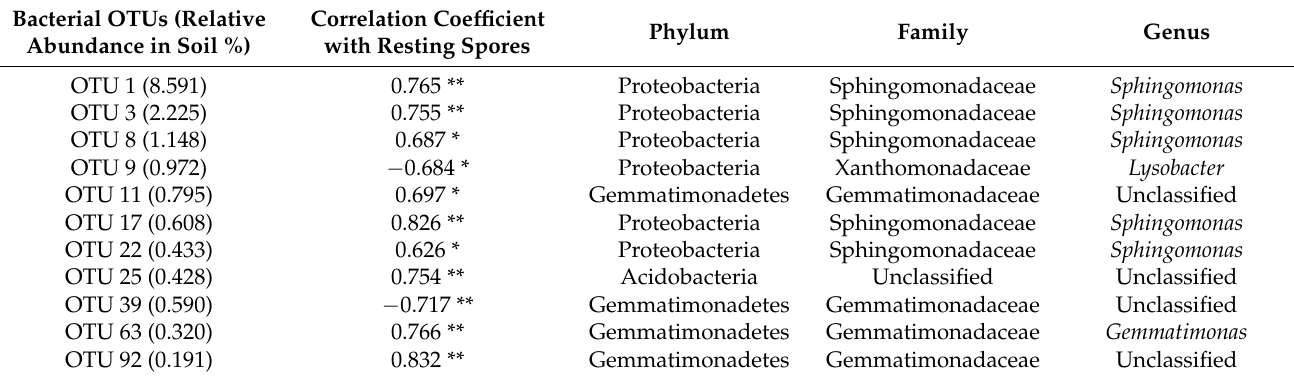
Table 4. Correlation analysis between resting spores and soil bacterial OTUs.